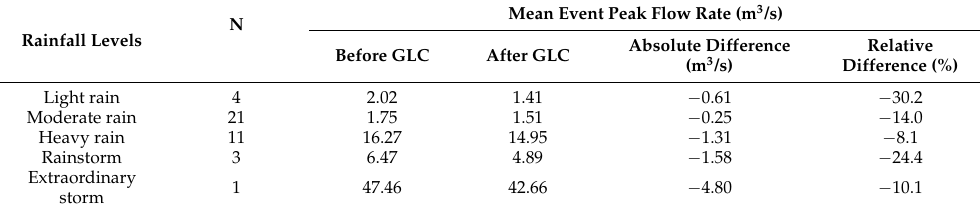
Table 6. Peak flow rate before and after the implementation of GLC.